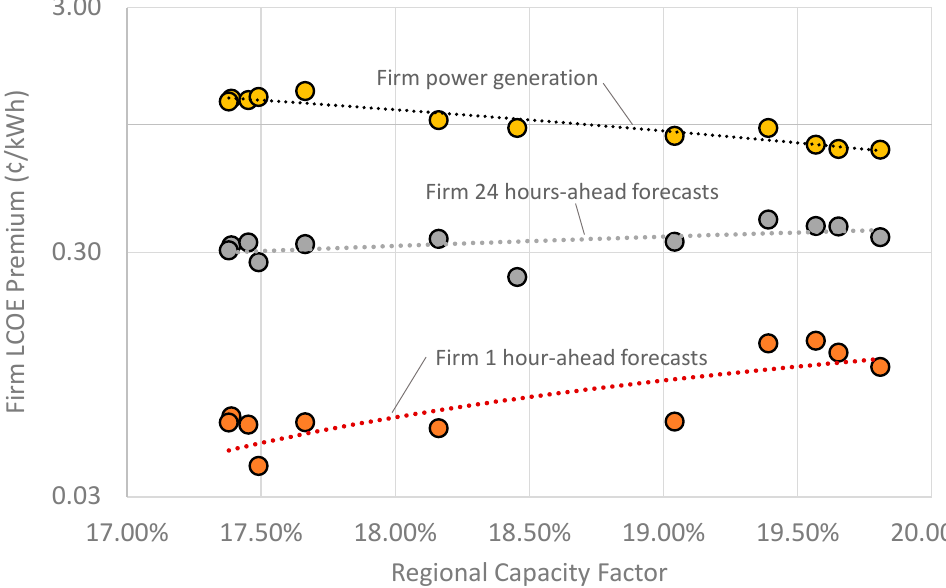
Figure 11. Firm LCOE premium as a function of regional capacity factor and firm load target.